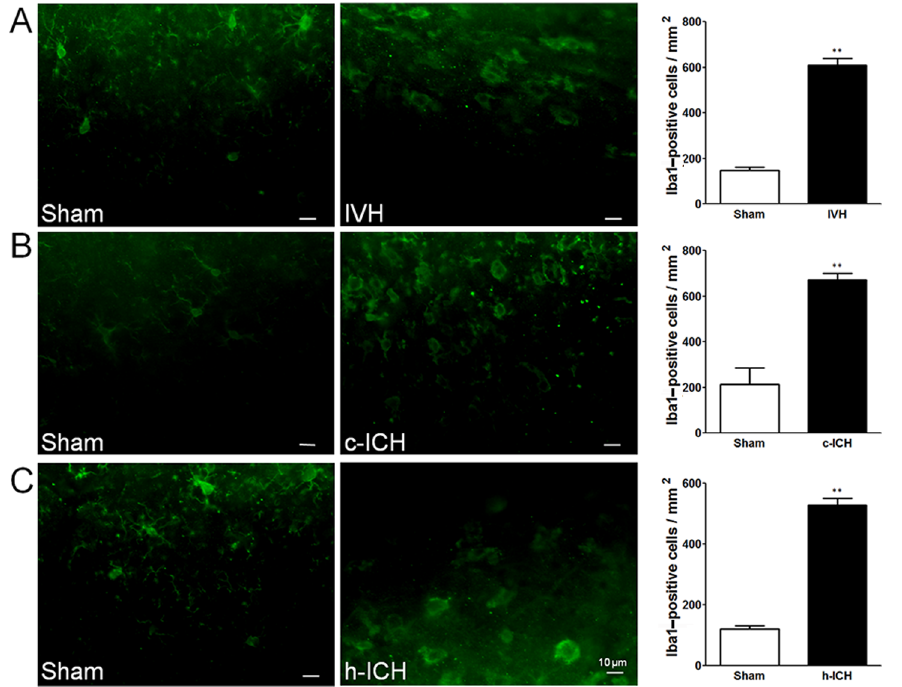
Figure 3. Microglia/macrophage activation is elevated 72 h after intracerebral hemorrhage (ICH) in ventricle, cortex, and hippocampus. Staining for Iba1 revealed activated microglia/macrophages in the brain regions around the lateral ventricles 72 h after intraventricular hemorrhage (IVH; A) and in the perihematomal regions of the frontal cortex (B) and hippocampus (C) 72 h after cerebral ICH (c-ICH) and hippocampal ICH (h-ICH), respectively. Quantification analysis showed that the number of activated microglia/macrophages in the IVH, c-ICH, and h-ICH groups was significantly greater than that in the respective sham groups (n=5 mice per group). Scale bar =10 m m. Values are means 6 SD; ** p , 0.01, t-test.